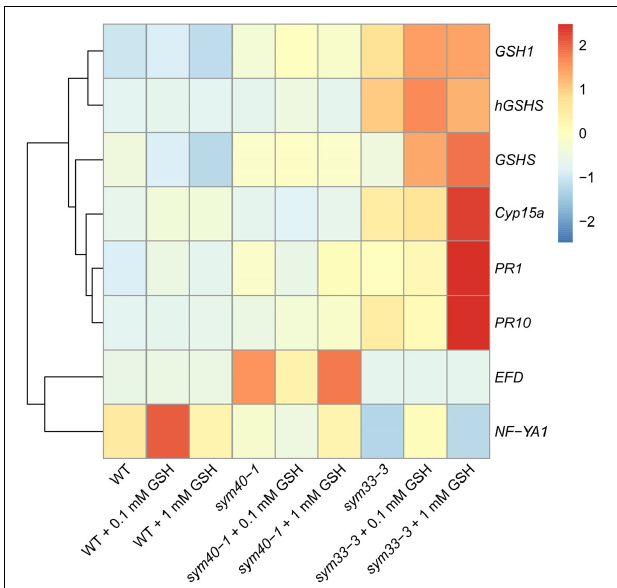
FIGURE 10 | Heatmap showing relative gene expression levels in 2-week-old roots with nodules from wild-type and mutant pea ( Pisum sativum ) plants treated with 0.1 mM or 1 mM glutathione (GSH). Transcript levels were determined by real-time PCR and calculated using the (cid:49) CT method, with glyceraldehyde-3-phosphate dehydrogenase ( GAPC1 ) serving as the reference gene. The color scale shows relative expression values for each gene after Z -transformation. The heatmap is based on data provided in Supplementary Table 3 (list 3). Gene expression levels were compared using one-way ANOVA, a P -value < 0.05 was considered significant [see also Supplementary Table 3 (list